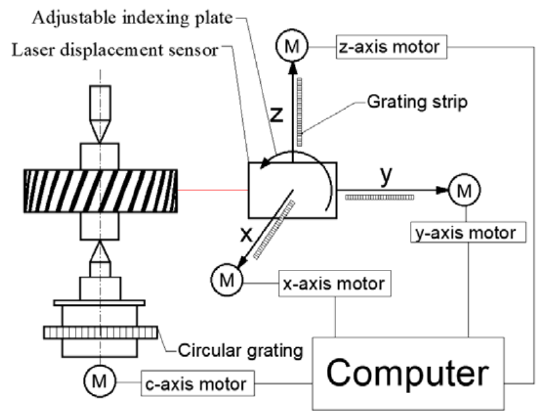
Figure 2. The specific structure of the laser measurement platform.